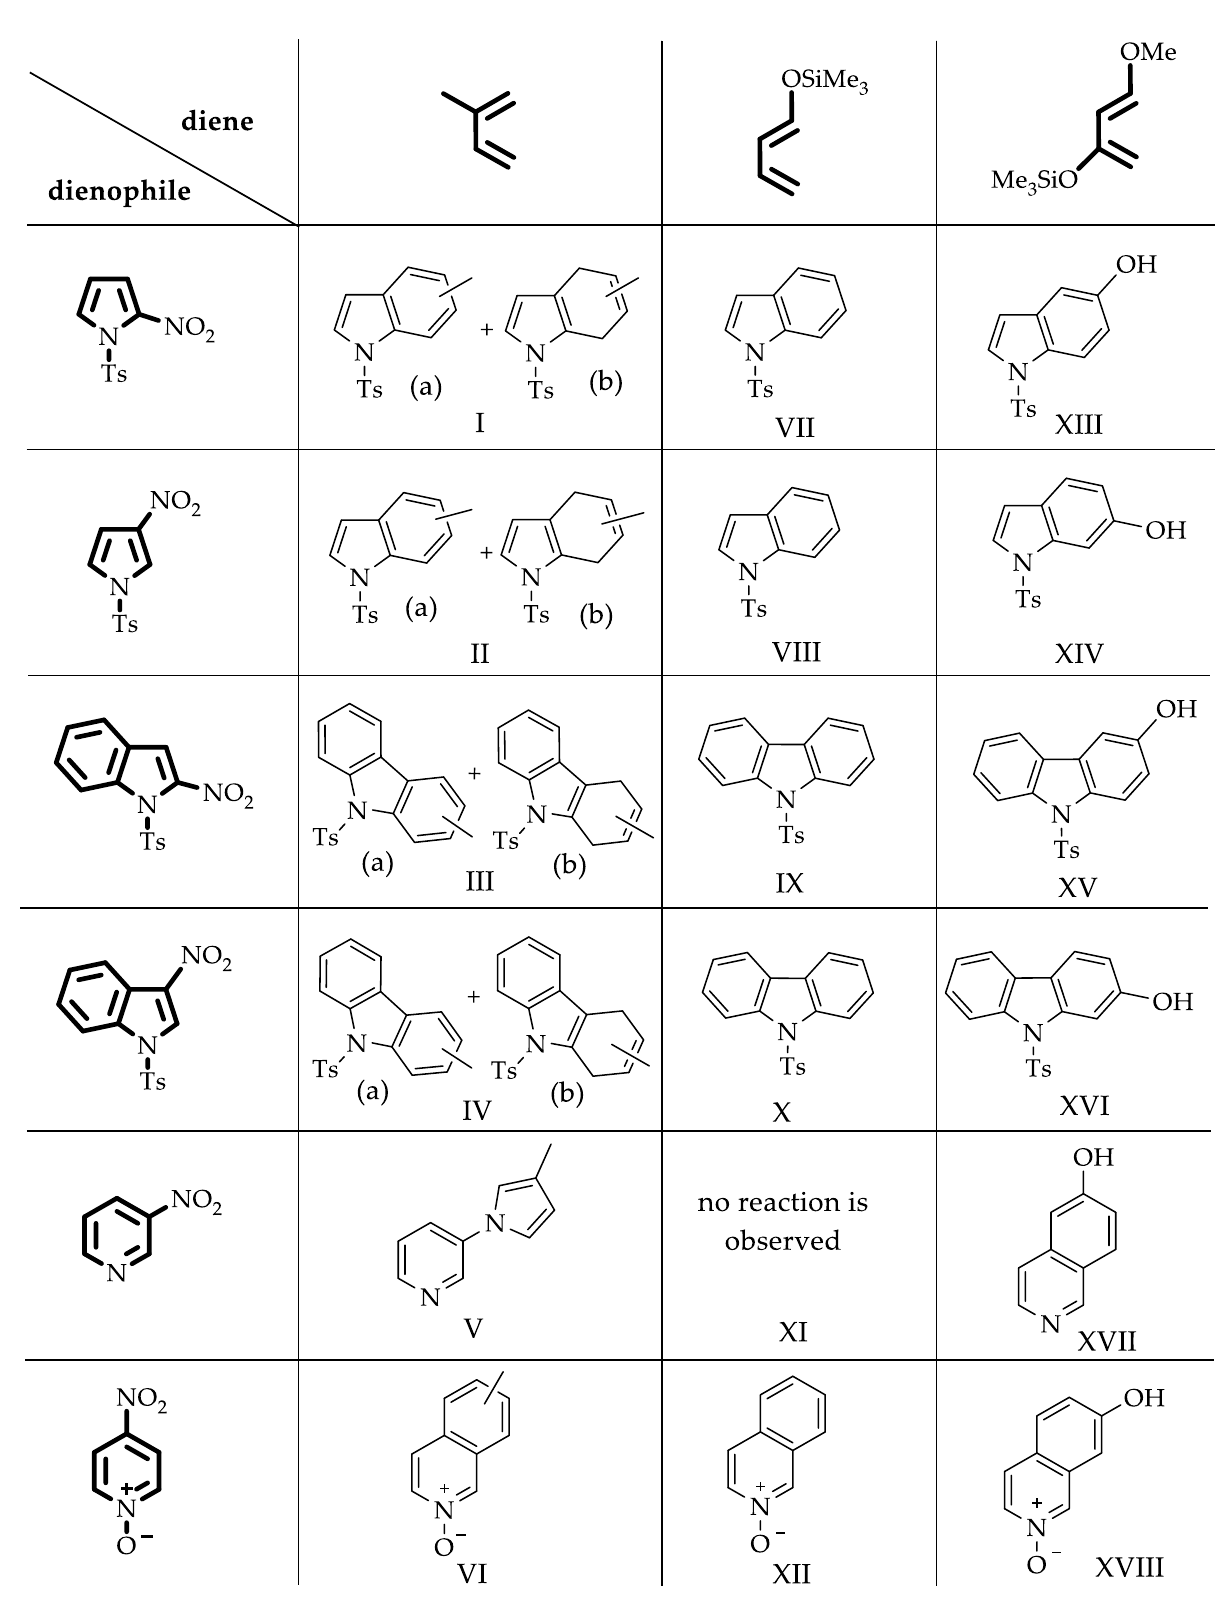
Figure 1. Reaction products of DA cycloadditions between azaheterocycles dienophiles and the different dienes. Table 1. Yields obtained from the reaction products of the DA cycloadditions. Reaction